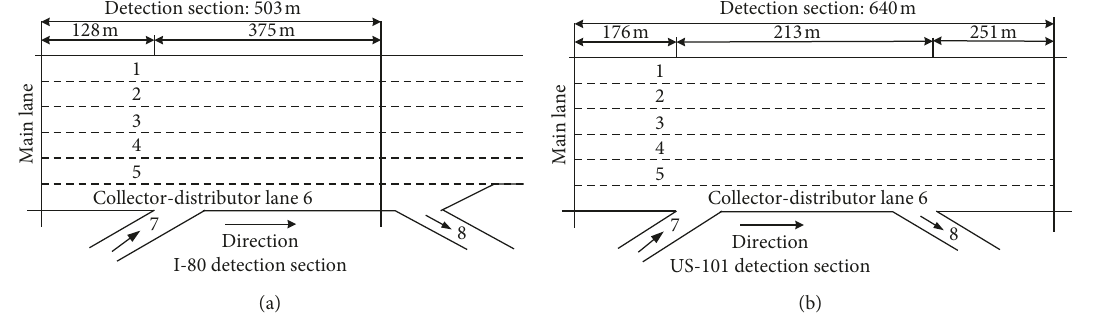
Figure 1: (a) I-80 and (b) US-101 detection section schematic sections.